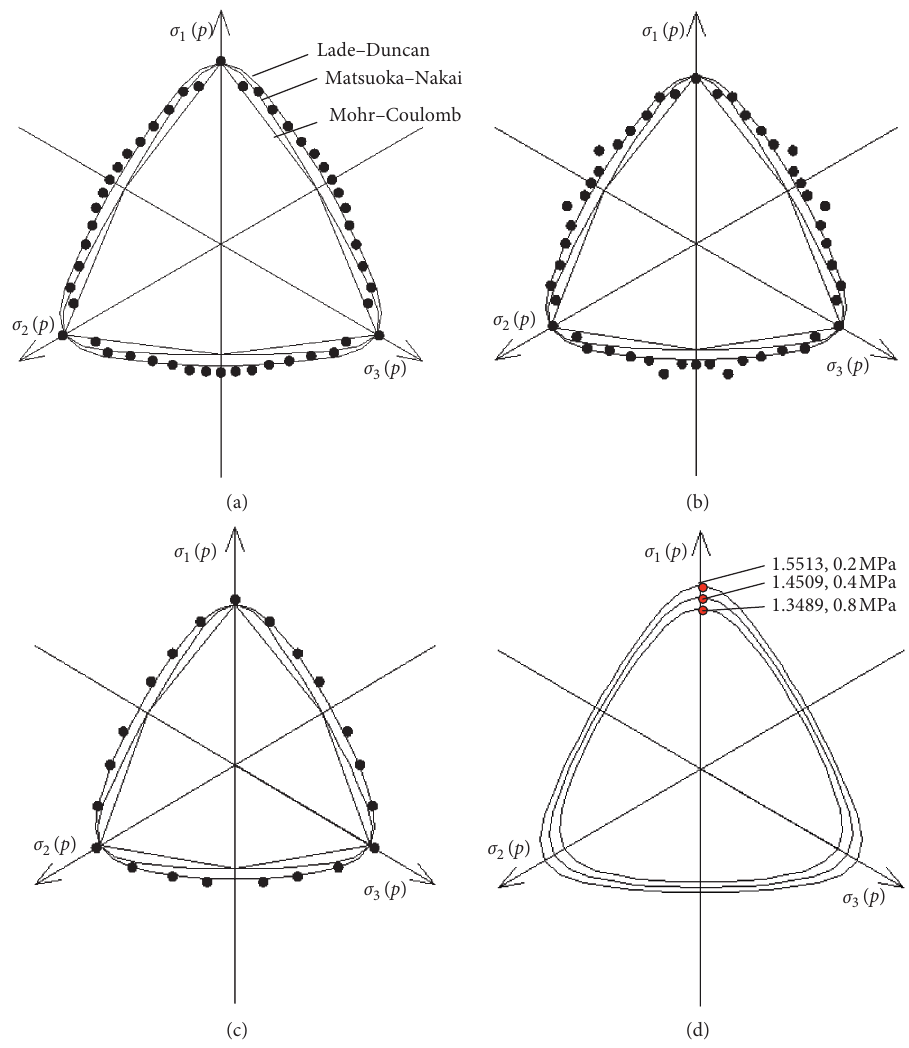
� 0.2 MPa; (b) σ � 0.4 MPa; (c) σ � 0.8 MPa; 3 3 3